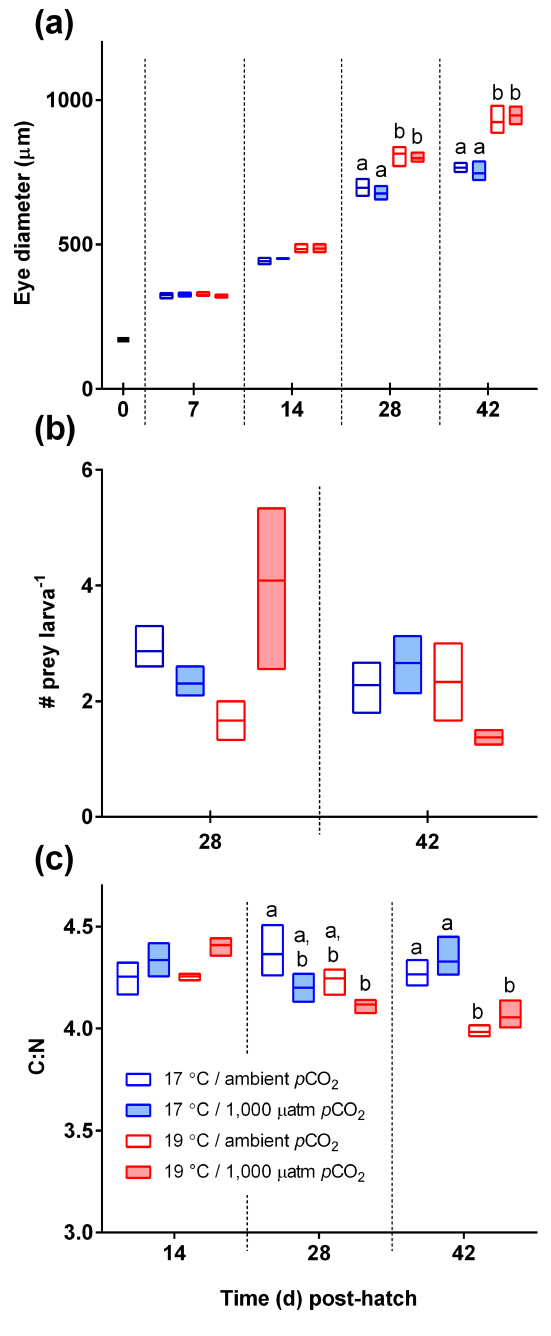
Fig. 4. (a) Eye diameter of D. labrax larvae incubated for 42 days under each experimental condition. (b) The number of Artemia salina prey in the gut of D. labrax larvae at d 28 and d 42 under each experimental condition. (c) C:N ratios of D. labrax larvae at d 14 , d 28 and d 42 under each experimental condition. Bottom and top of floating bars are minimum and maximum values, horizontal lines are means. Columns that do not share a letter are significantly differ- ent (two-way ANOVA with Bonferroni post-test, P < 0 . 05). Mean values ± 1SEM, N =3. See Table 1 for details on each experimental condition.